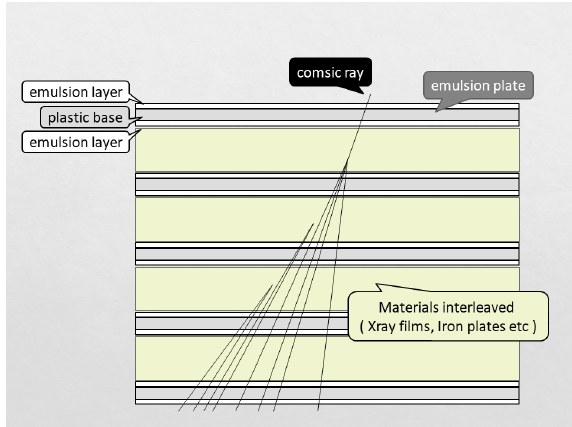
Fig 3. A schematic picture of a cosmic ray interaction occurring and recorded in an emulsion chamber.